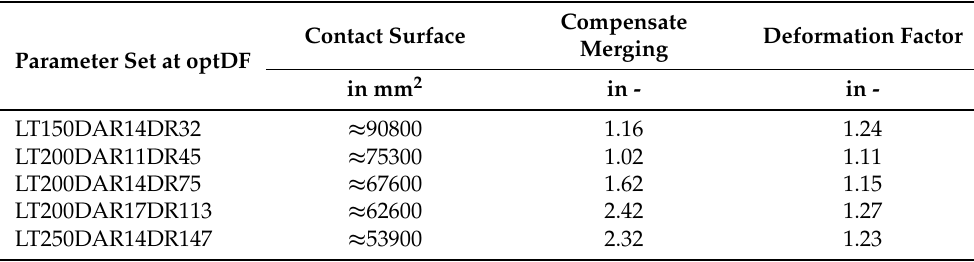
Table 5. For the difference in residual porosity between the parameter sets, three explanations are presented with abbreviations for the